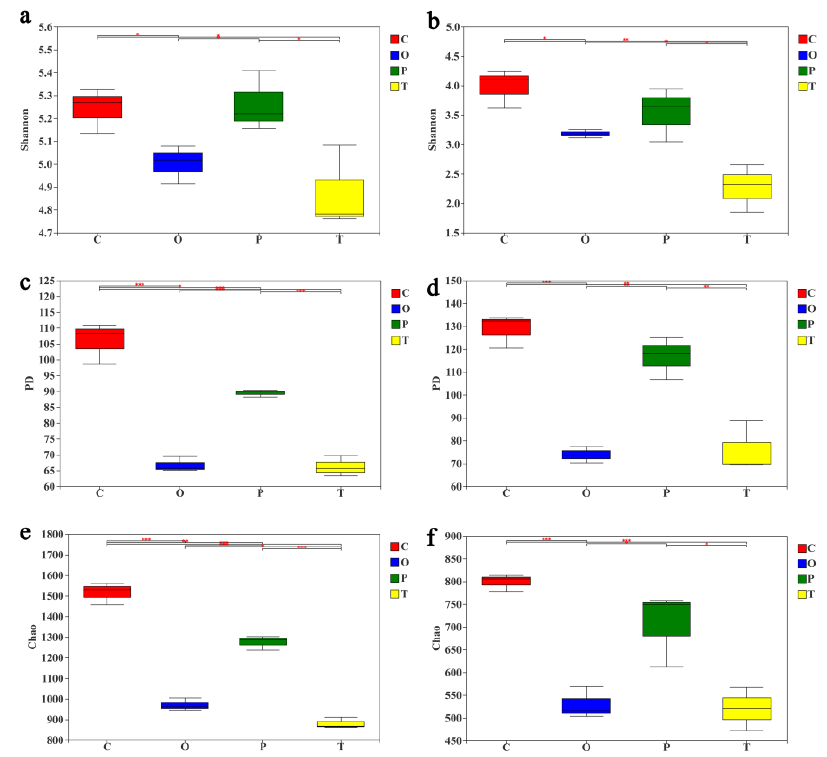
Figure 3. Comparative analysis of the alpha diversity of 16S rRNA and ITS rRNA soil microbe se- quences from moss-dominated biocrust soils. ( a ) and ( b ) Shannon; ( c ) and ( d ) Phylogenetic diversity; and ( e ) and ( f ) Chao1 were calculated by moss type. The data were rarefied up to 35,000 counts per sample. The left boxplots show bacteria diversity and the right for fungi. Statistically significant dif- ferences (* p < 0.05, ** p < 0.01, *** p < 0.001) were determined by one-way ANOVA followed by post hoc Tukey test. Red color was assigned to Claopodium rugulosifolium soil; cyan to Orthotrichum courtoisii soil; green to Polytrichum formosum soil; yellow to Taxiphyllum giraldii soil. C: Claopodium rugulosifolium ; O: Orthotrichum courtoisii ; P: Polytrichum formosum ; T: Taxiphyllum giraldii .